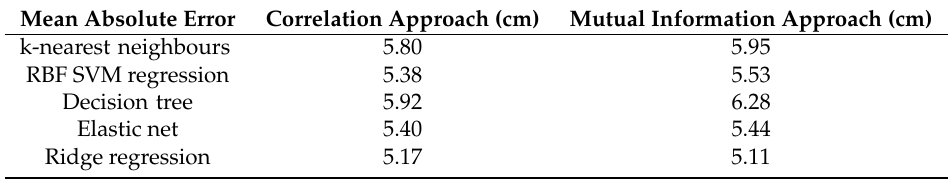
Table 9. Leave-one-subject-out (LOSO) cross validated mean absolute error for our step length estimation